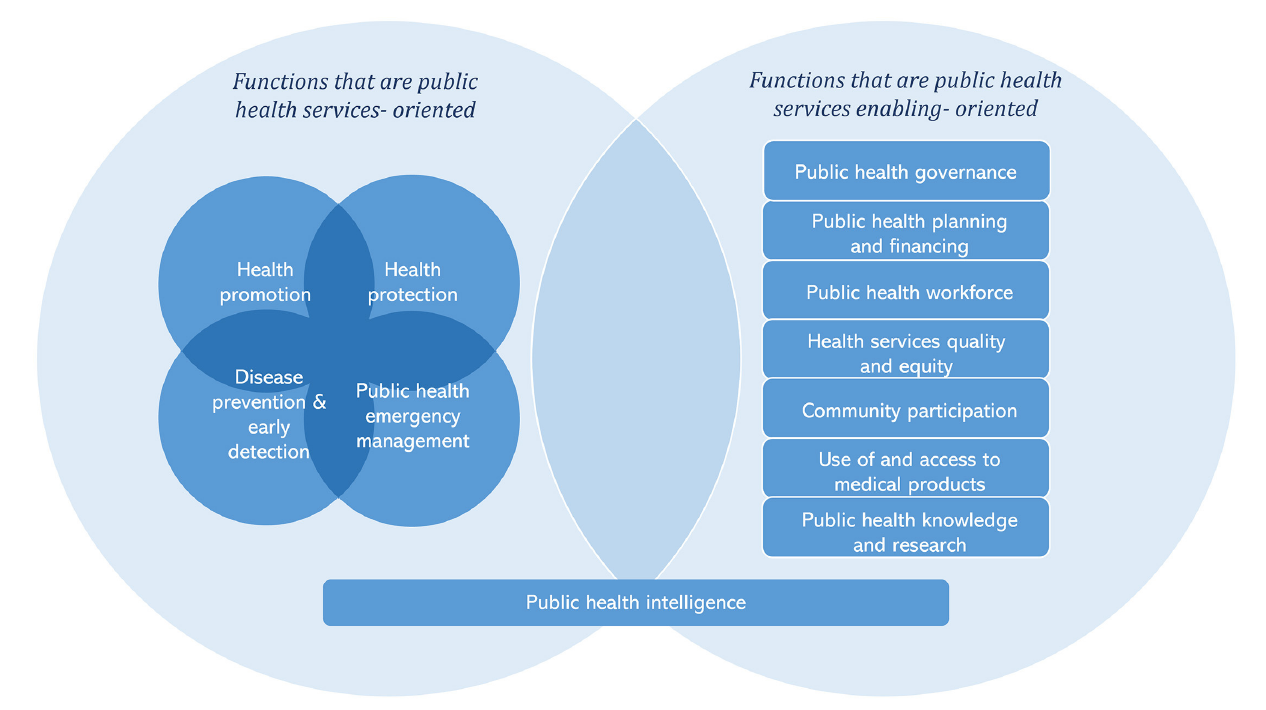
FIGURE1 Interlinked essential public health functions working together to provide public health services to the populations.